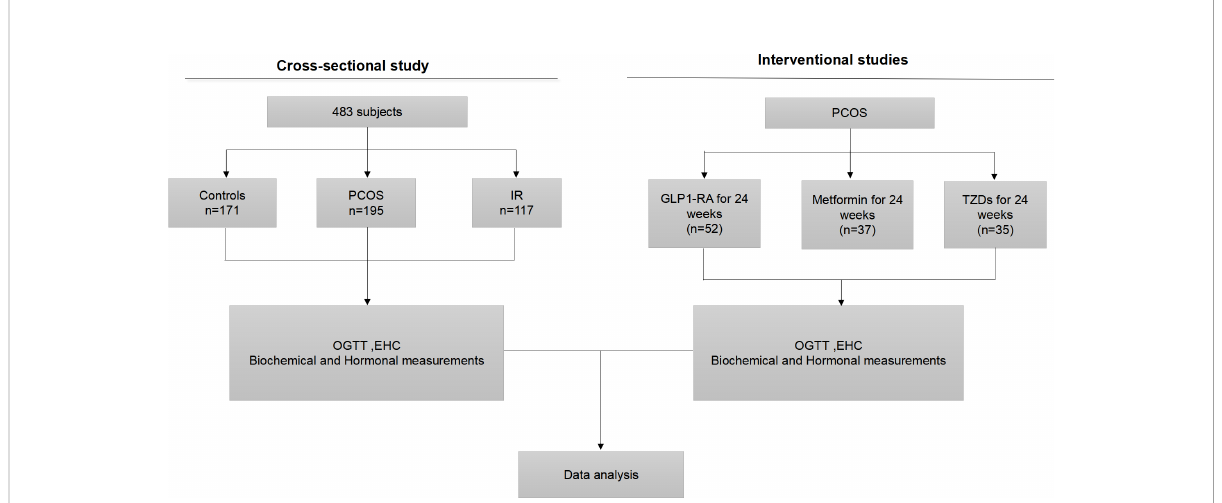
FIGURE 1 Experimental design. OGTT, oral glucose tolerance test; EHC, euglycemic- hyperinsulinemic clamp; GLP1-RA, glucagon-like peptide-1 receptor agonists; TZD,